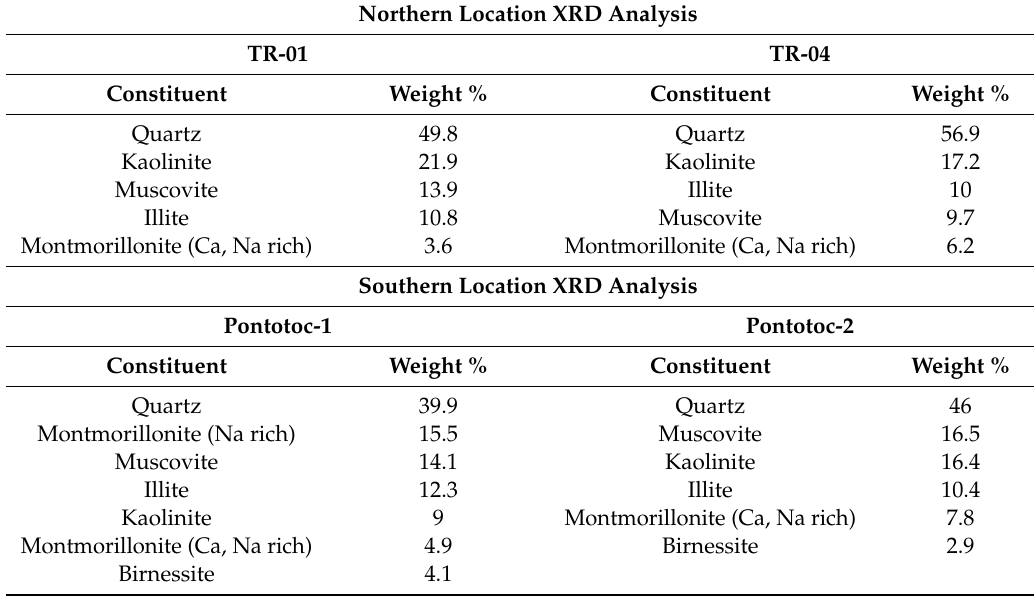
Table 2. X-ray Di ff raction analysis for two northern samples (TR-01 and TR-04) and two southern samples (Pontotoc-1 and